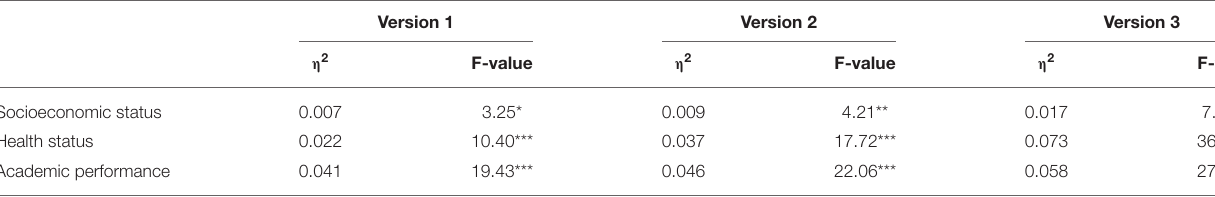
TABLE 5 | Known-group validity